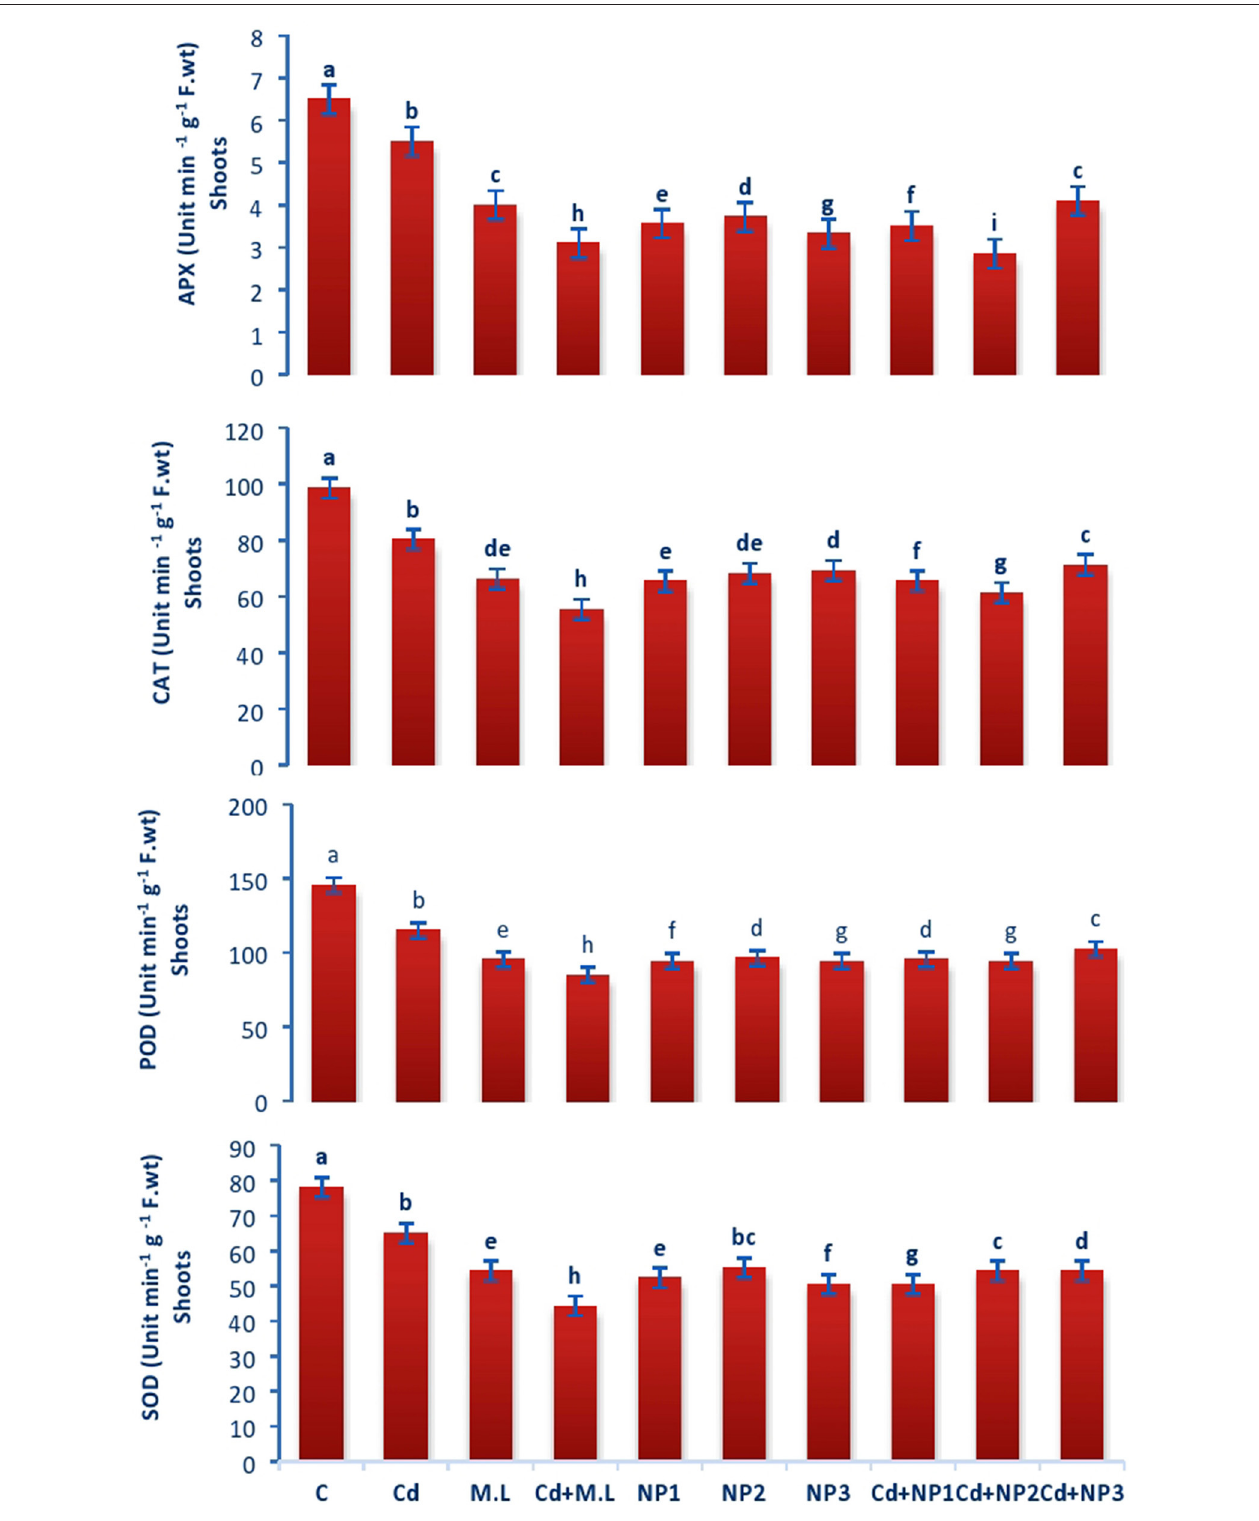
FIGURE 6 | Effects of MZnO–NPs on APX, CAT, POD, and SOD under Cd stress in Linseed shoots. Different letters indicate significant difference between the treatments. Data are means ± SE ( n = 5). Non-identical letters specify significant difference at P ≤ 0.05. C, Control; Cd, 100mg kg − 1 Cd; M. L, Moringa oleifera leaves; NP1, 100mg L − 1 MZnO-NPs; NP2, 500mg L − 1 MZnO-NPs; NP3, 1g L − 1 MZnO-NPs.